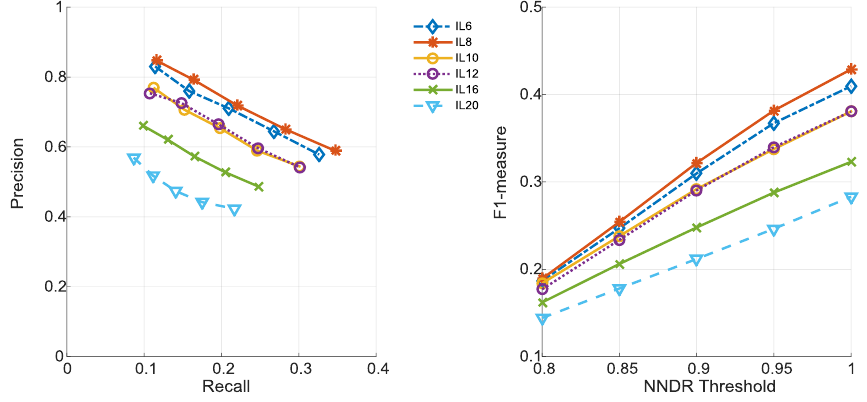
Figure 10. The average PR curve and F1-measure curve results of parameter I L ( C L = 20).